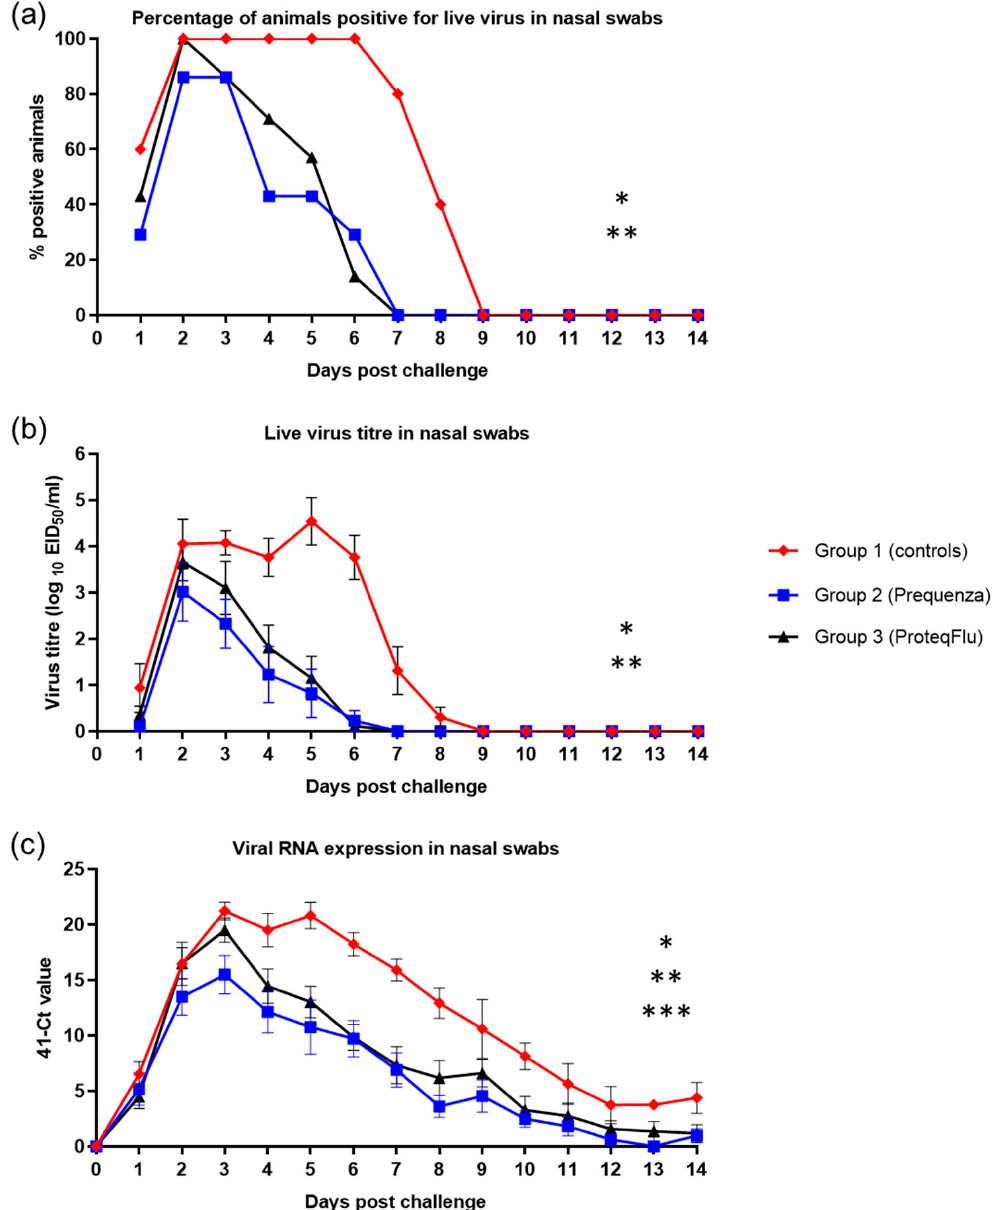
Figure 7. ( a ) Percentage of horses positive for live virus in nasal swabs, ( b ) Live virus titre in nasal swabs and ( c ) Amount of viral RNA expression in nasal swabs in groups 1–3 after challenge with H3N8 A / equi-2 / Wexford / 14 (FC2 sublineage). Red diamond = group 1, unvaccinated control group; blue square = group 2, Equilis Prequenza-vaccinated group; black triangle = group 3, ProteqFlu-vaccinated group. Error bars represent SEM. Inferential statistics: significant difference ( p < 0.05) in the AUC between groups 1 and 2 (*), groups 1 and 3 (**) and groups 2 and 3 (***) (mean effect between 1 and 14 dpc).